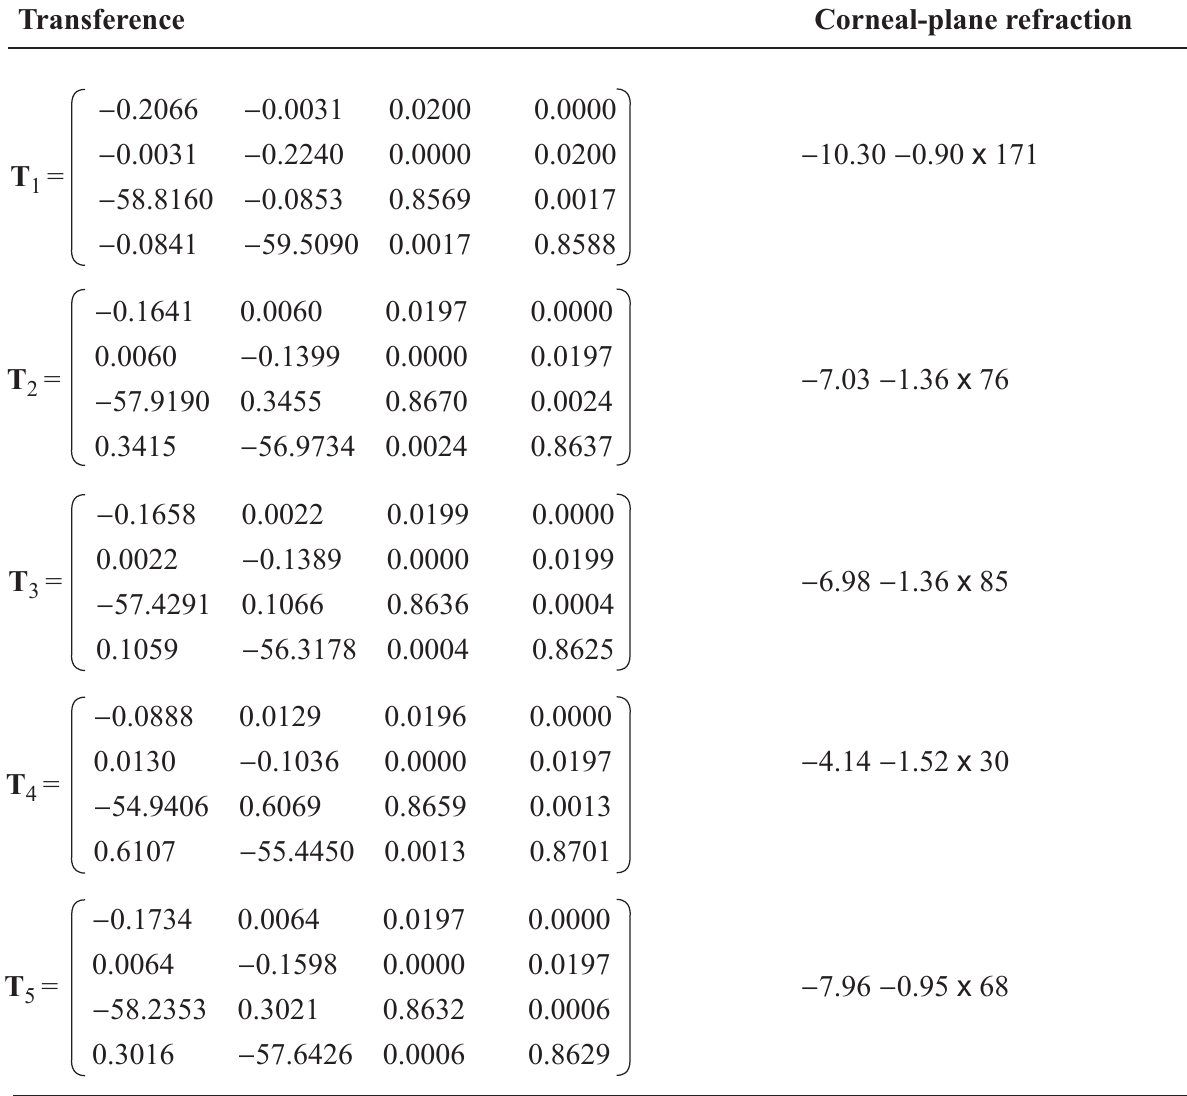
Table 1 The ray transferences of the first five in a set of 30 randomly-generated myopic eyes. The corneal-plane refractions are given for interest. The refracting elements have been assumed all to be centred on the common longitudinal axis; the fifth row and column of each transference are trivial and omitted. The units are m for the top-right 2 x 2 submatrix and D for the bottom- left 2 x 2